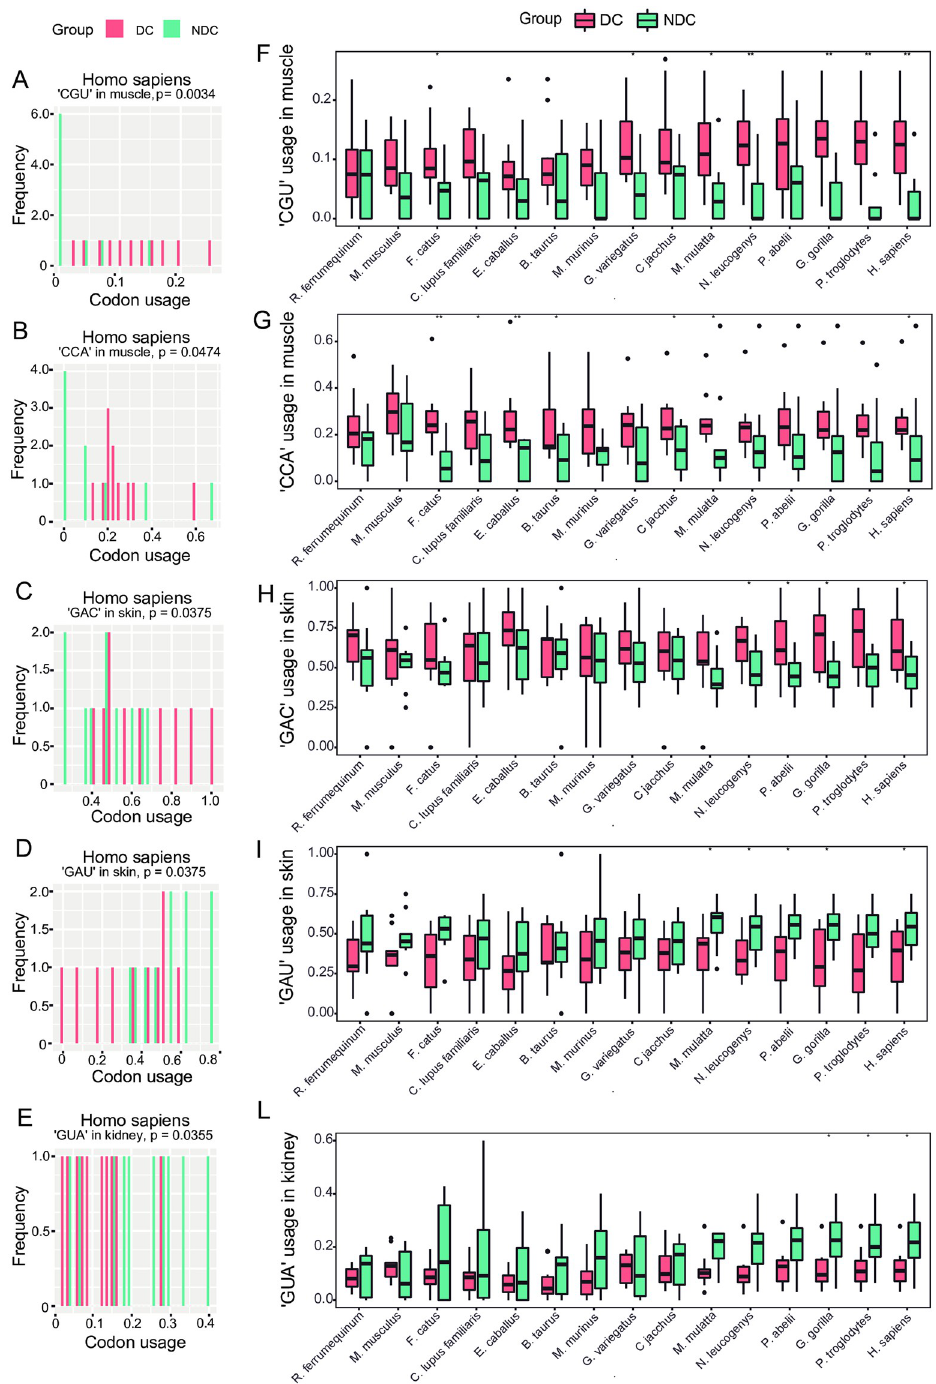
Fig 4. The 5 extremely biased codons, differentially used by Homo sapiens in DC vs NDC genes, and among tissues. Left graphs (A, B, C, D, E) show the codon frequency on the x-axis and the number of genes that use that specific codon (with the frequency annotate in x-axis) on the y-axis. Right graphs (F, G, H, I, L) show CU values in all studied mammals on the x-axis and codon usage values in gene tissues on the y-axis. Five codons were the most differentially used in HSA , CGU (Arg), CCA (Pro), GAC (Asp), GAU (Asp), and GUA (Val). Pink bars indicate DC genes, blue bars indicate NDC genes. CGU (A, F) is the least frequently used codon in NDC muscle genes; CCA (B, G) is the least frequently used codon in DC muscle genes; GAC (C, H) is the most frequently used codon in DC skin genes; GAU (D, I) is the most frequently used codon in NDC skin genes; GUA (E, L) is the least frequently used codon